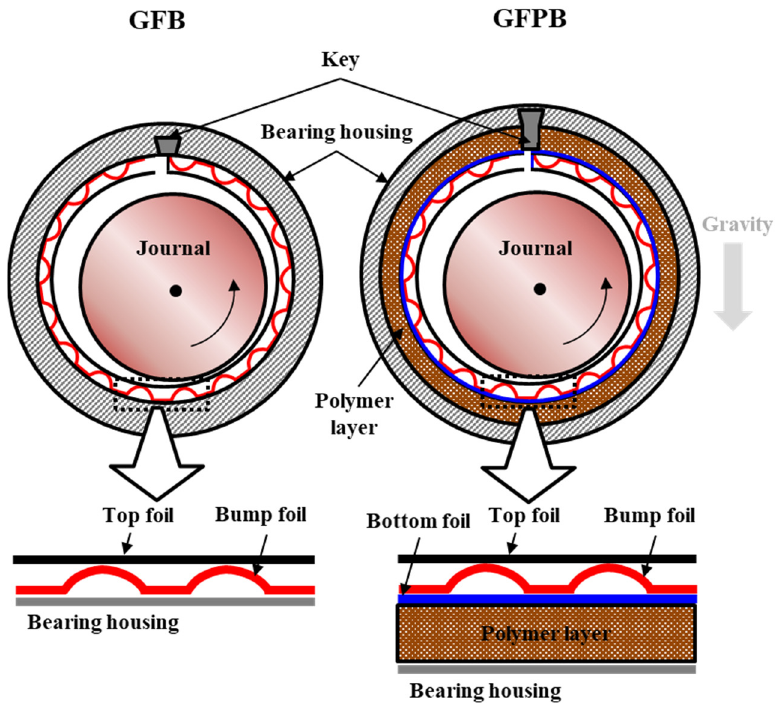
Figure 1. Schematic view of a one-pad journal GFB and GFPB and their sub-structures